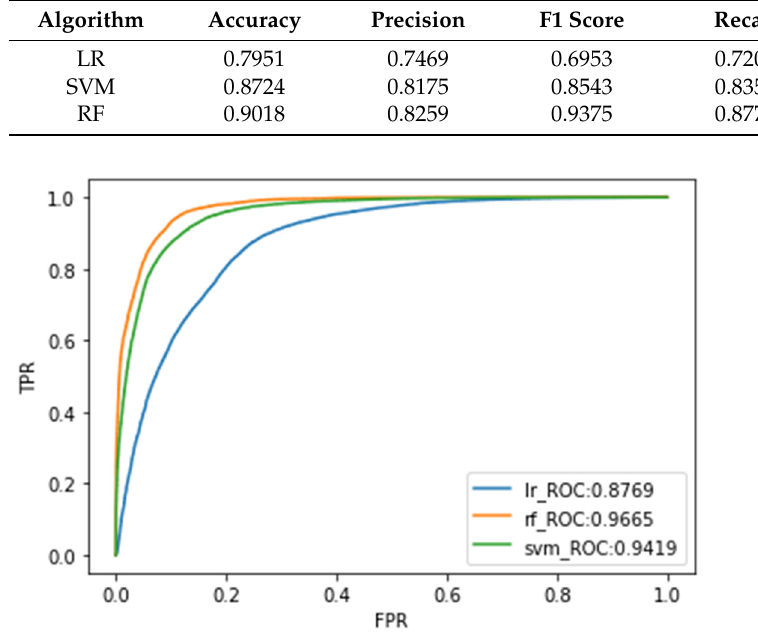
Figure 9. The ROC of preliminary LSM models (random forest, LR and SVM are represented by orange, blue and green, respectively).